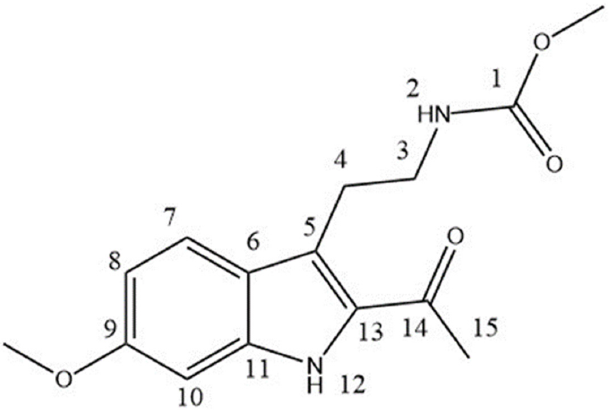
Figure 5. Mass spectrum of PH ‐ HM ‐ 10.